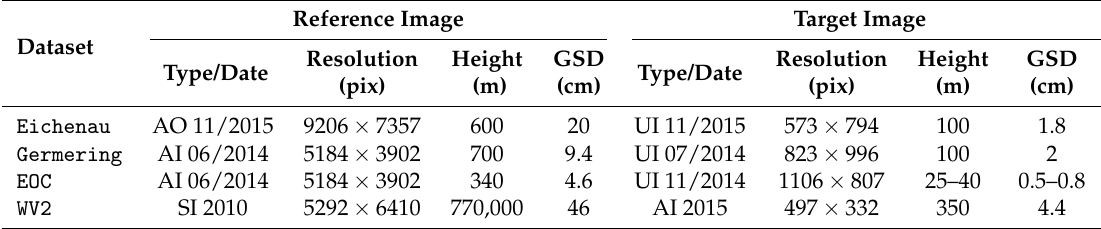
Table 6. Characteristics of the datasets used in the experiment. Target images are pre-aligned towards the reference image using GNSS/IMU data. AI: aerial imagery; AO: aerial orthophoto; SI: satellite imagery; UI: UAV